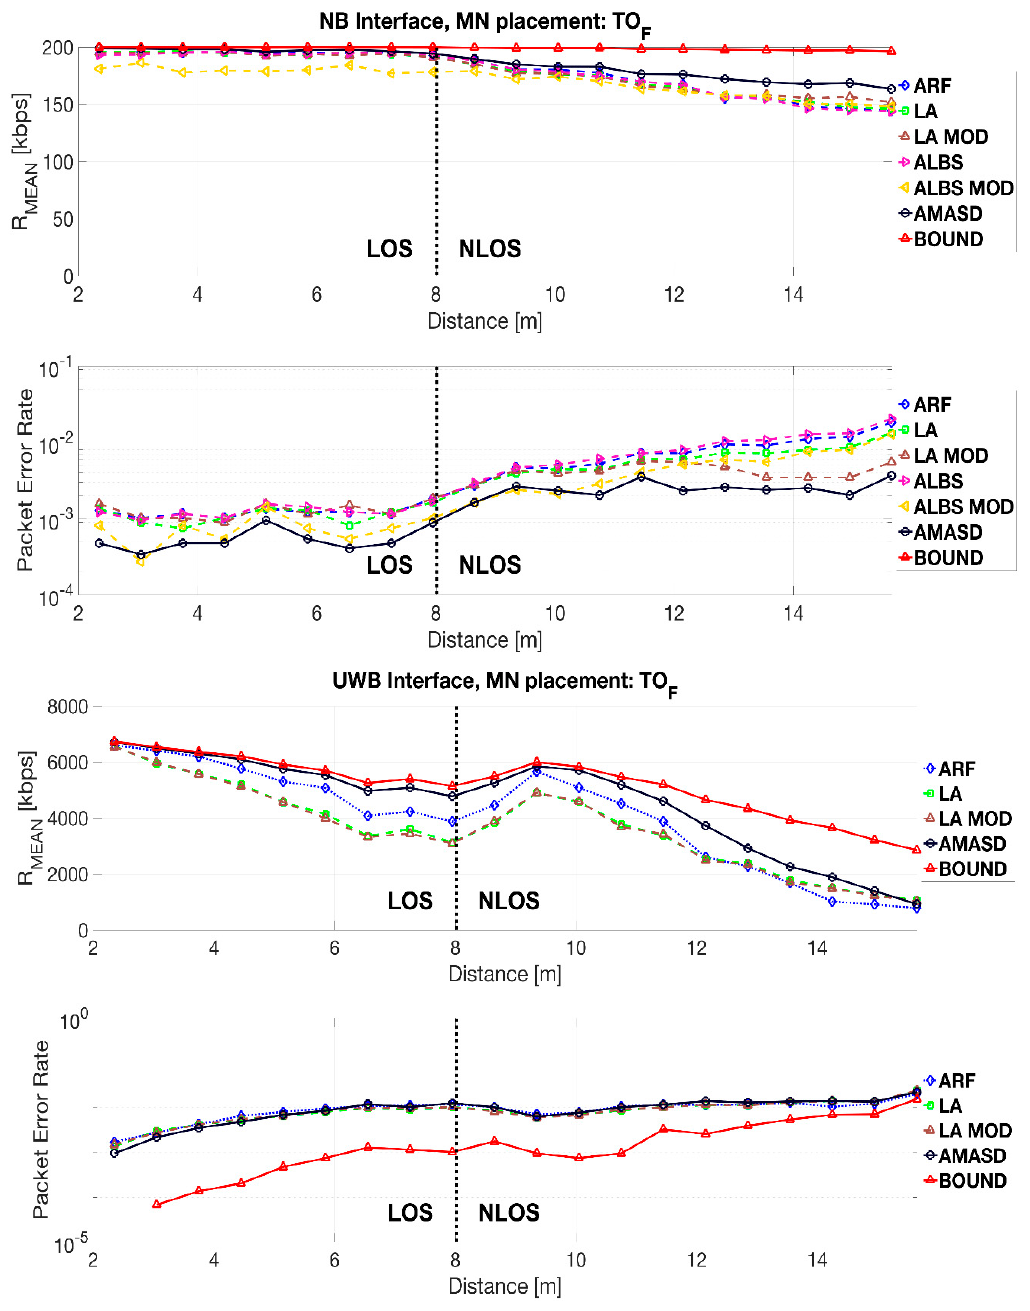
Figure 9. The R MEAN and PER results as a function of the distance for the TO F MN placement for the NB and the UWB interfaces .